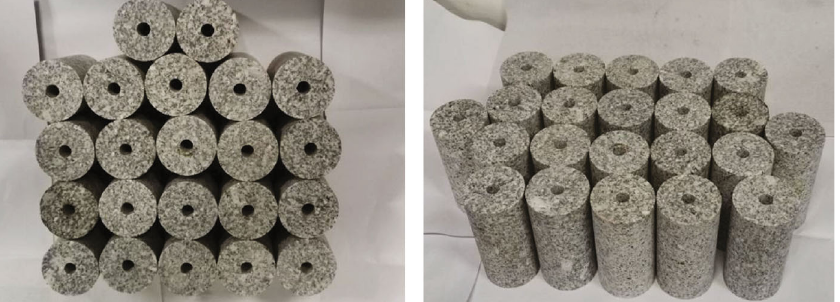
Figure 2: Rock test samples.